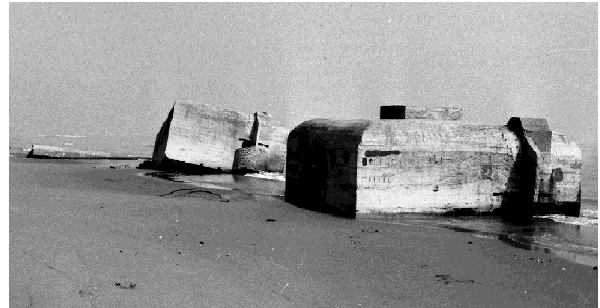
Figure 1. Lido di Savio (RA), Abandoned bunkers along the beach. © Giordani,